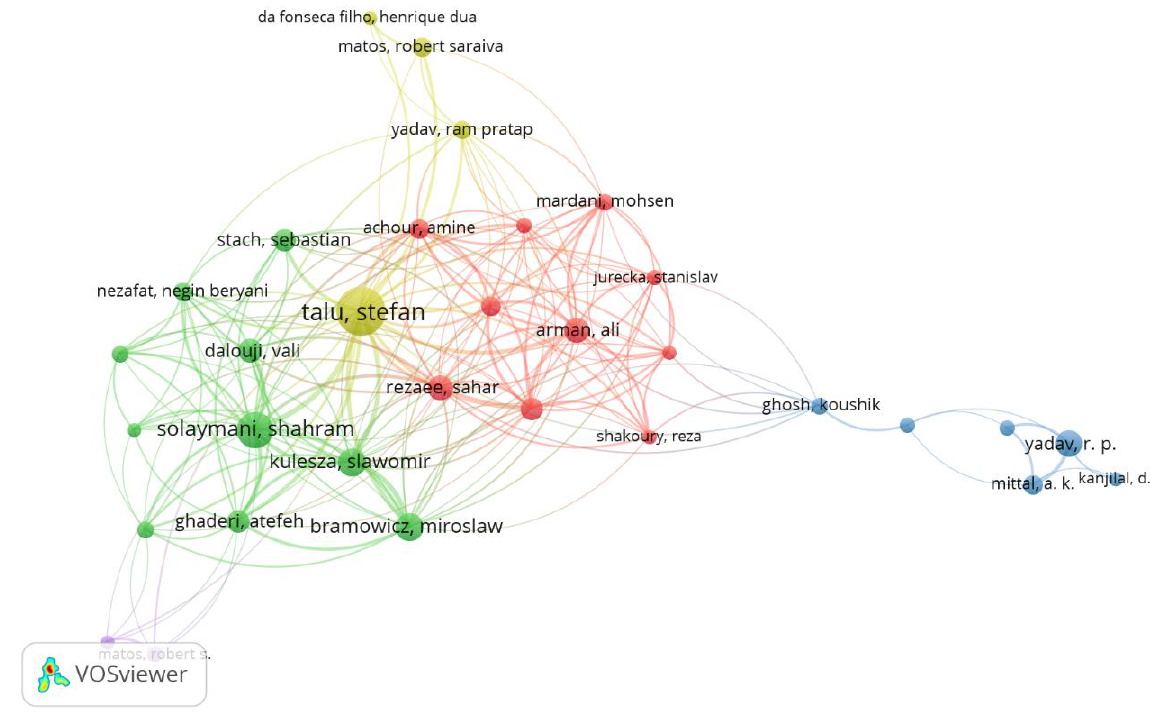
Figure 13. Expanded view of Figure 12 showing co-authorship of authors publishing in fractal theory in thin film applications.